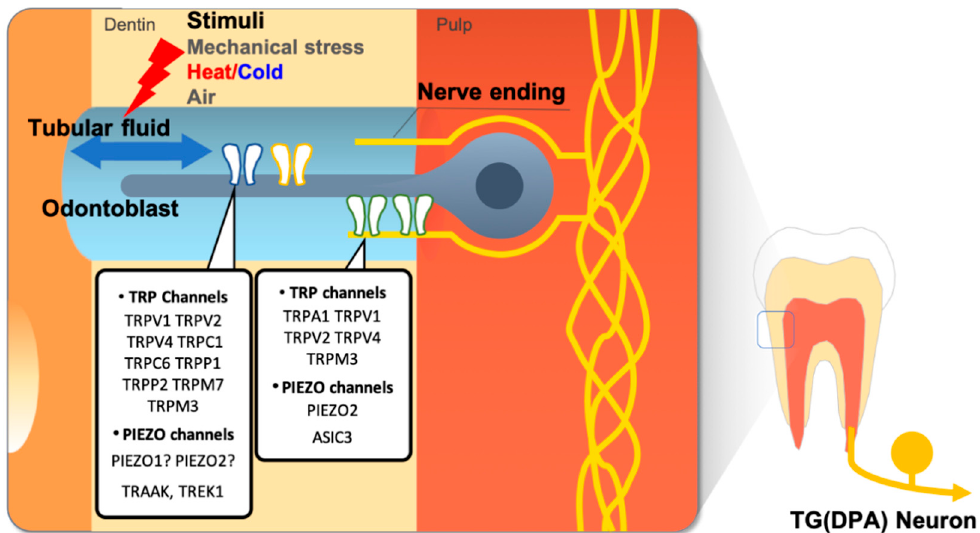
Figure 3. Mechanosensitive ion channels in the dental sensory system. According to the hydrodynamic theory of dental nociception, movement of the dentine tubular fluid generated by external stimuli, such as thermal or mechanical stress, activates mechanosensitive ion channels in odontoblasts or dental primary afferent (DPA) nerve ending extend into the dentinal tubule. Thus, mechanosensitive ion channels are regarded as major players in dental nociception. These ion channels can also be activated with directly applied mechanical stress.